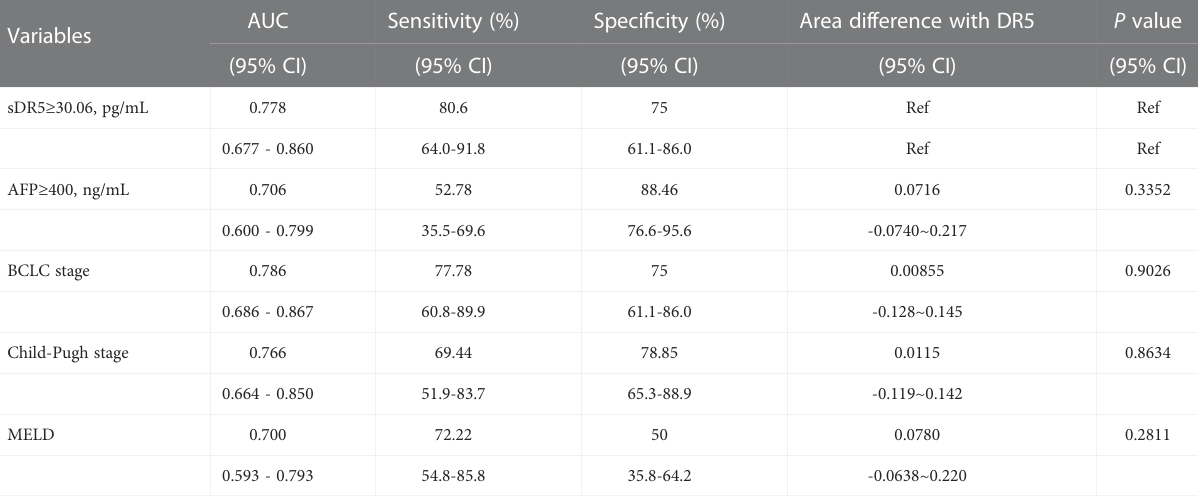
TABLE 5 Predictive value of the DR5, AFP, BCLC stage, Child-pugh stage and MELD score in validation cohort.